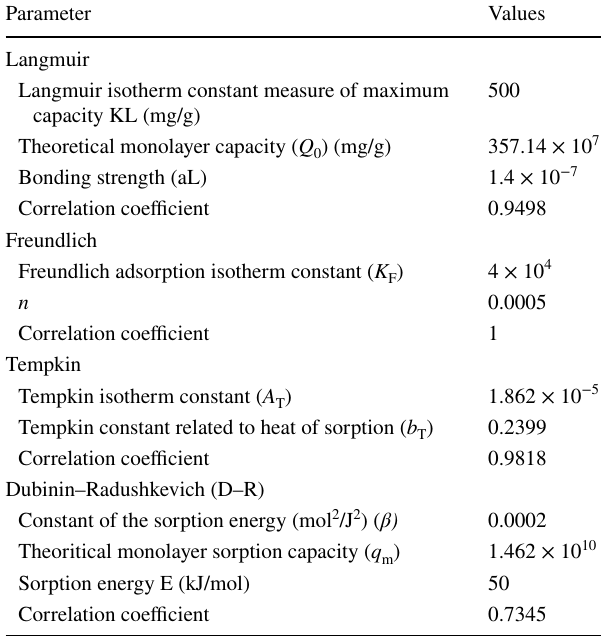
Table 4 The studied isotherm parameters of